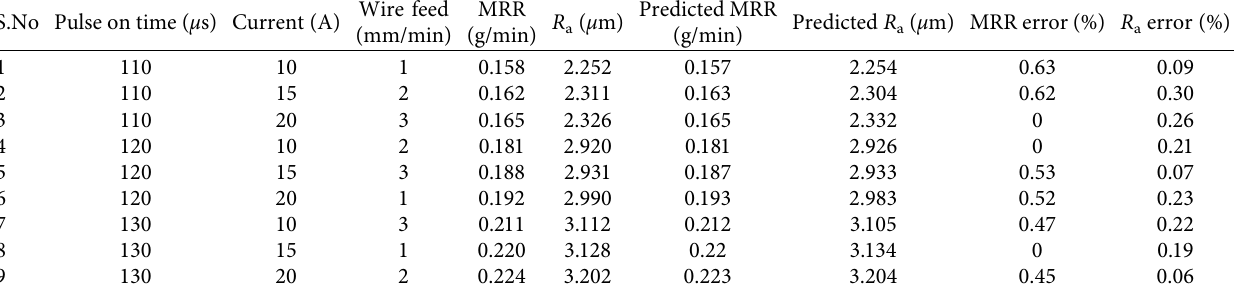
Table 3: Experimental results of Taguchi-based DOE.